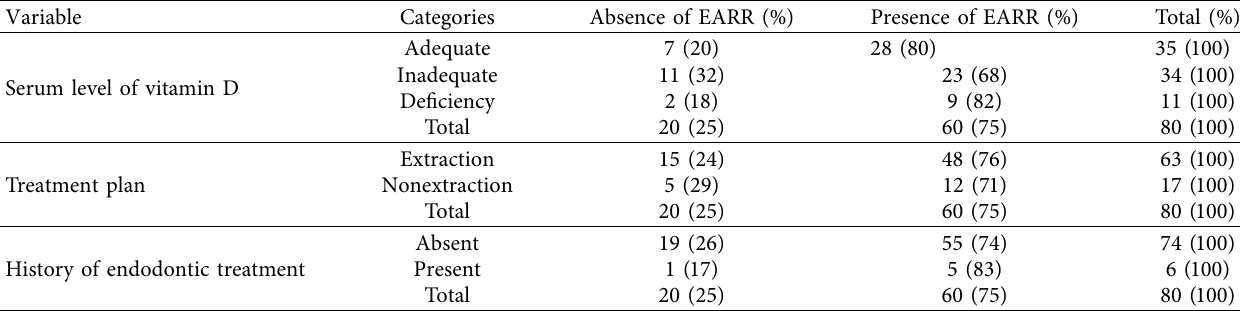
Table 3: Frequency of EARR in patients based on serum level of vitamin D, orthodontic treatment plan (extraction versus nonextraction), and endodontic treatment of